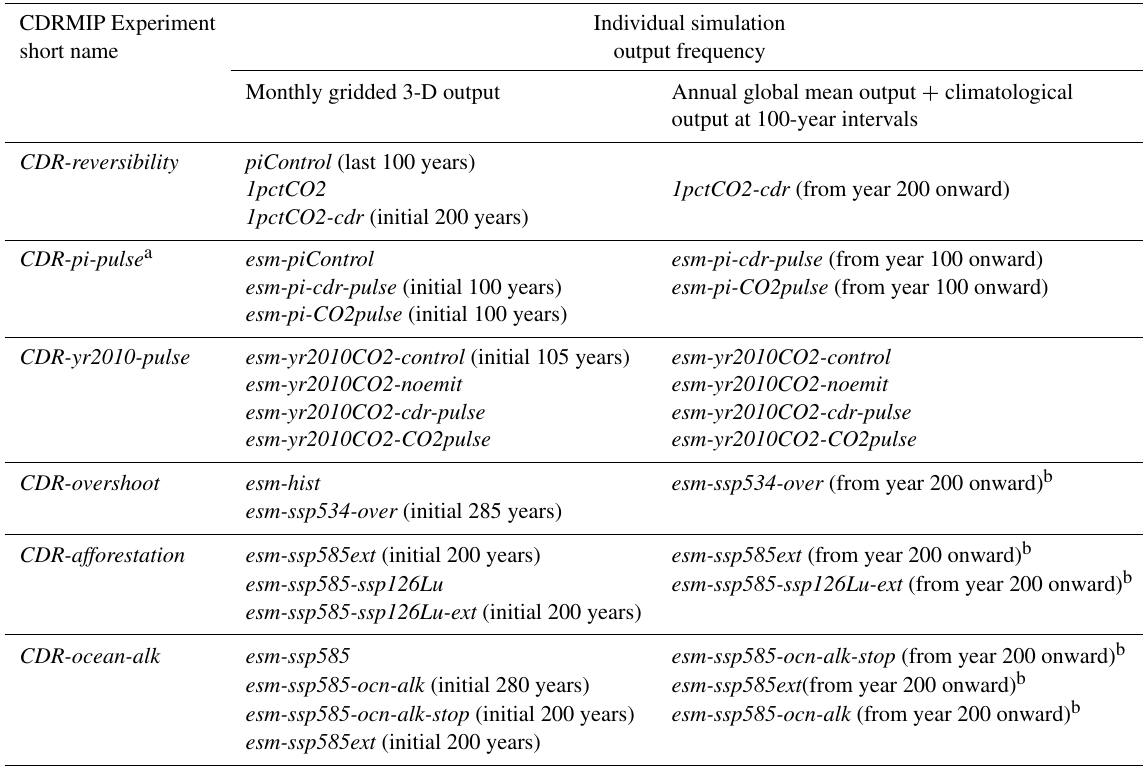
Table 8. Model output frequency for 3-D models with seasonality. Box models and EMICs without seasonality are expected to generate annual global mean output for the duration of all experiments. For longer simulations (right column), if possible, 3-D monthly data should be written out for 1 year every 100 years. For models with interannual variability, for example ESMs, monthly data should be written out for a 10-year period every 100 years so that a climatology may be developed. The years referred to in the table indicate simulations years, for example years from the start of the run, and not those of any particular